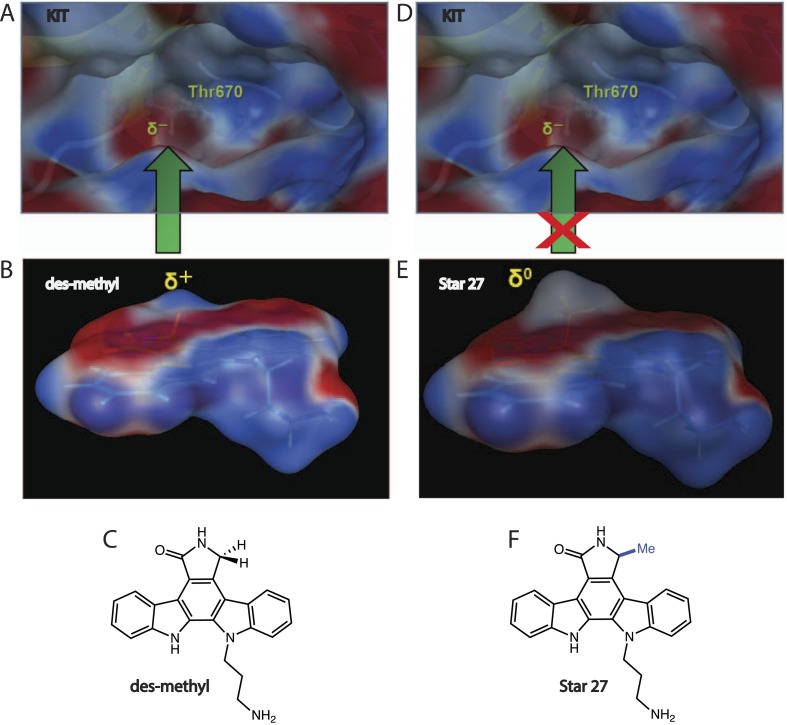
Electronic model of selectivity.Star 27-des methyl (PKC412-relevant) and Star 27 are depicted in 3D with electron potential mapping (EPM) to highlight the difference of a single methyl group. (A–C) Star 27-des methyl maintains a partial positive charge at the C7 position which matches the partial negative charge on the Thr 670 gatekeeper of KIT, potentially explaining PKC412's relative affinity for KIT. (D–F) Star 27 maintains a neutral charged surface at C7 due to the presence of the methyl group, potentially explaining its lack of binding to KIT.